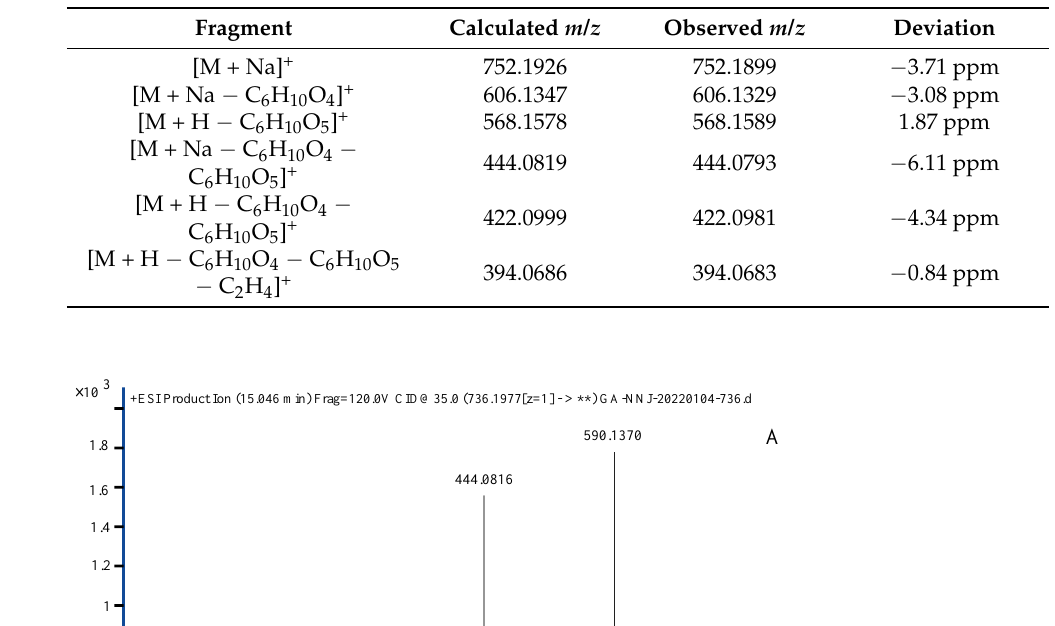
Table 5. The deviations between calculated and observed m / z values of each fragment derived from compound 5 .